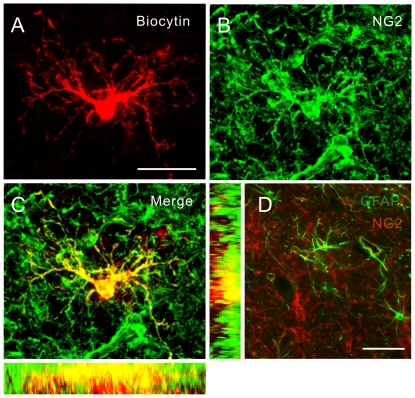

Post-hoc morphological and immunocytochemical analysis.(A) Two-photon image stack of a biocytin-filled NG2 cell stained with Alexa-594 conjugated streptavidin. Scale bar, 25 µm. (B) NG2 immunoreactivity of the same slice in (A). (C) Images of (A) and (B) are superimposed. Three orthogonal (xy, xz and yz) planes are shown. (D) Double immunofluorescent labeling of GFAP and NG2 proteins. Scale bar, 25 µm.